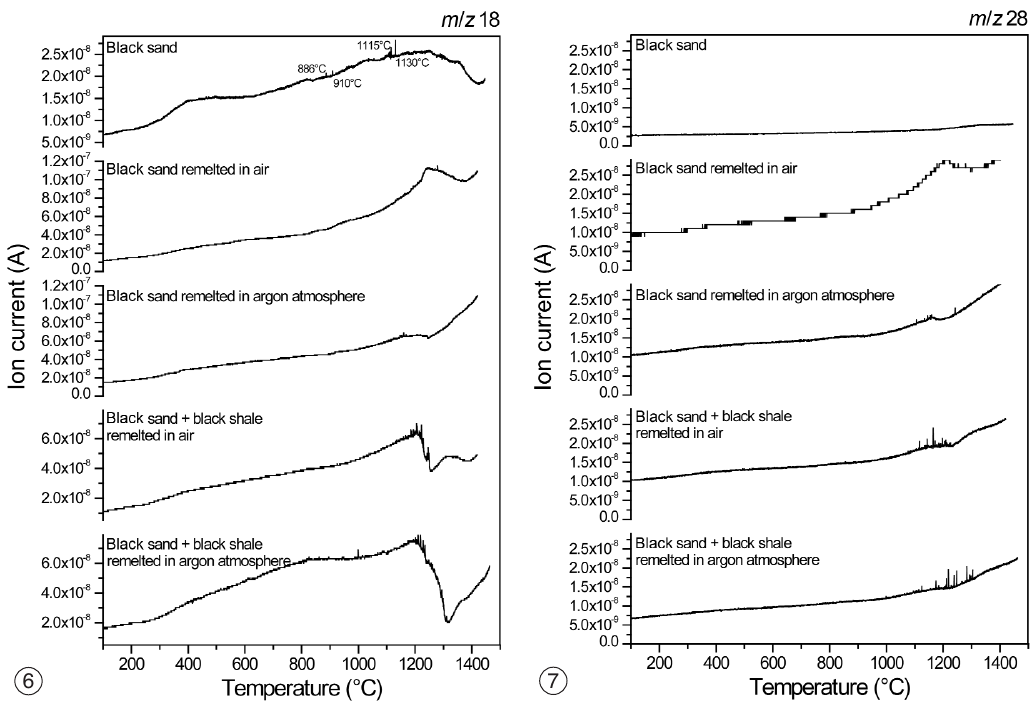
Fig. 6. Water release ( m / z = 18) from black sand and remelting products. Fig. 7. Change of partial pressure of the mass number m / z =